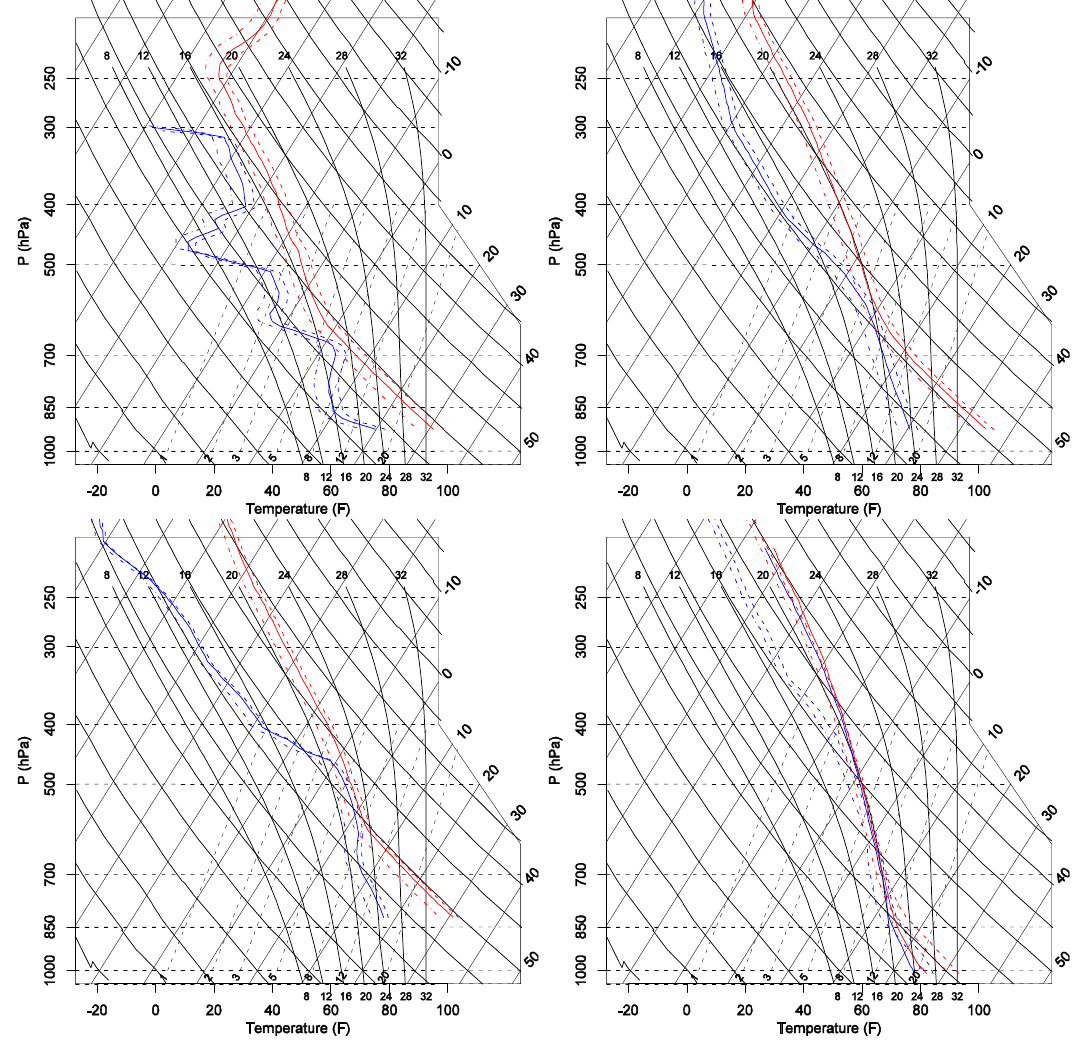
Fig. 1. Initial profiles used in model simulations: Montana (MO, top left), Texas (TX, top right), New Mexico (NM, bottom left) and Tropical Pacific (TP, bottom